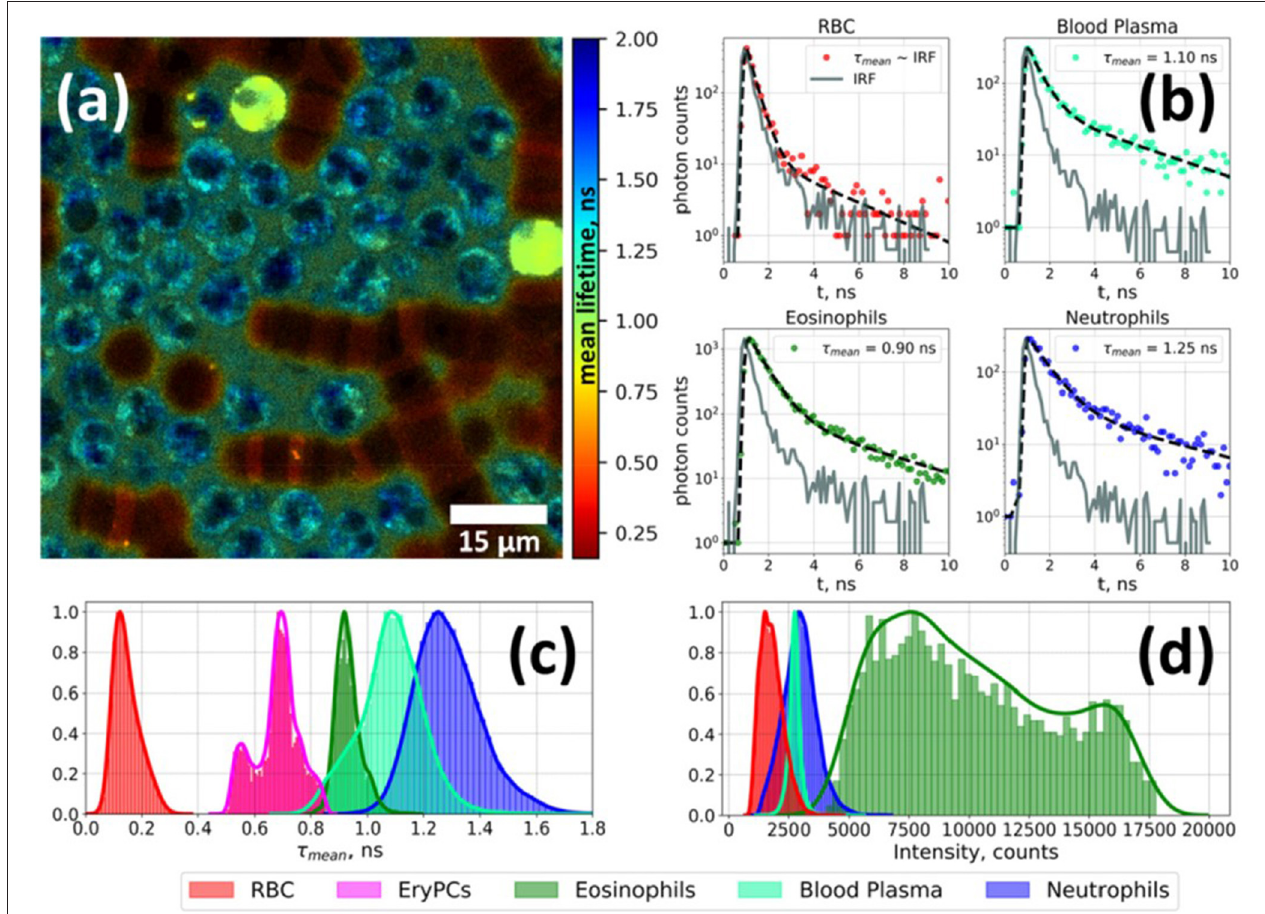
FIGURE 2 | Fluorescence lifetime imaging microscopy image of autofluorescence from a white blood cell-enriched sample excited at 402nm and collected at > 520nm (a) . Fluorescence decay curves for each blood-cell type was generated using time-correlated single-photon counting (TCSPC) along with a biexponential decay curve fit (b) . Plots of average fluorescence lifetime (c) and integral fluorescence intensity for each cell type (d) . Adapted with permission from [ 23] © The Optical